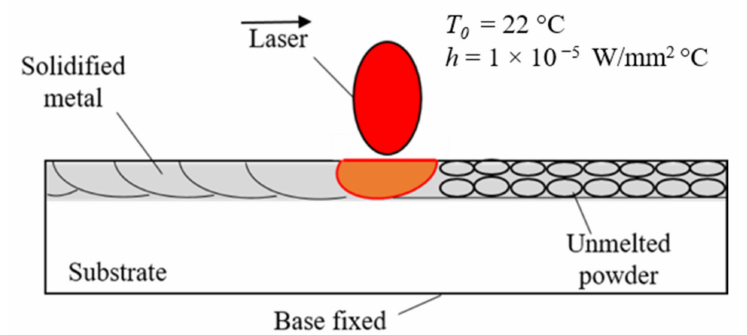
Figure 1. Representation of the AM process with thermal